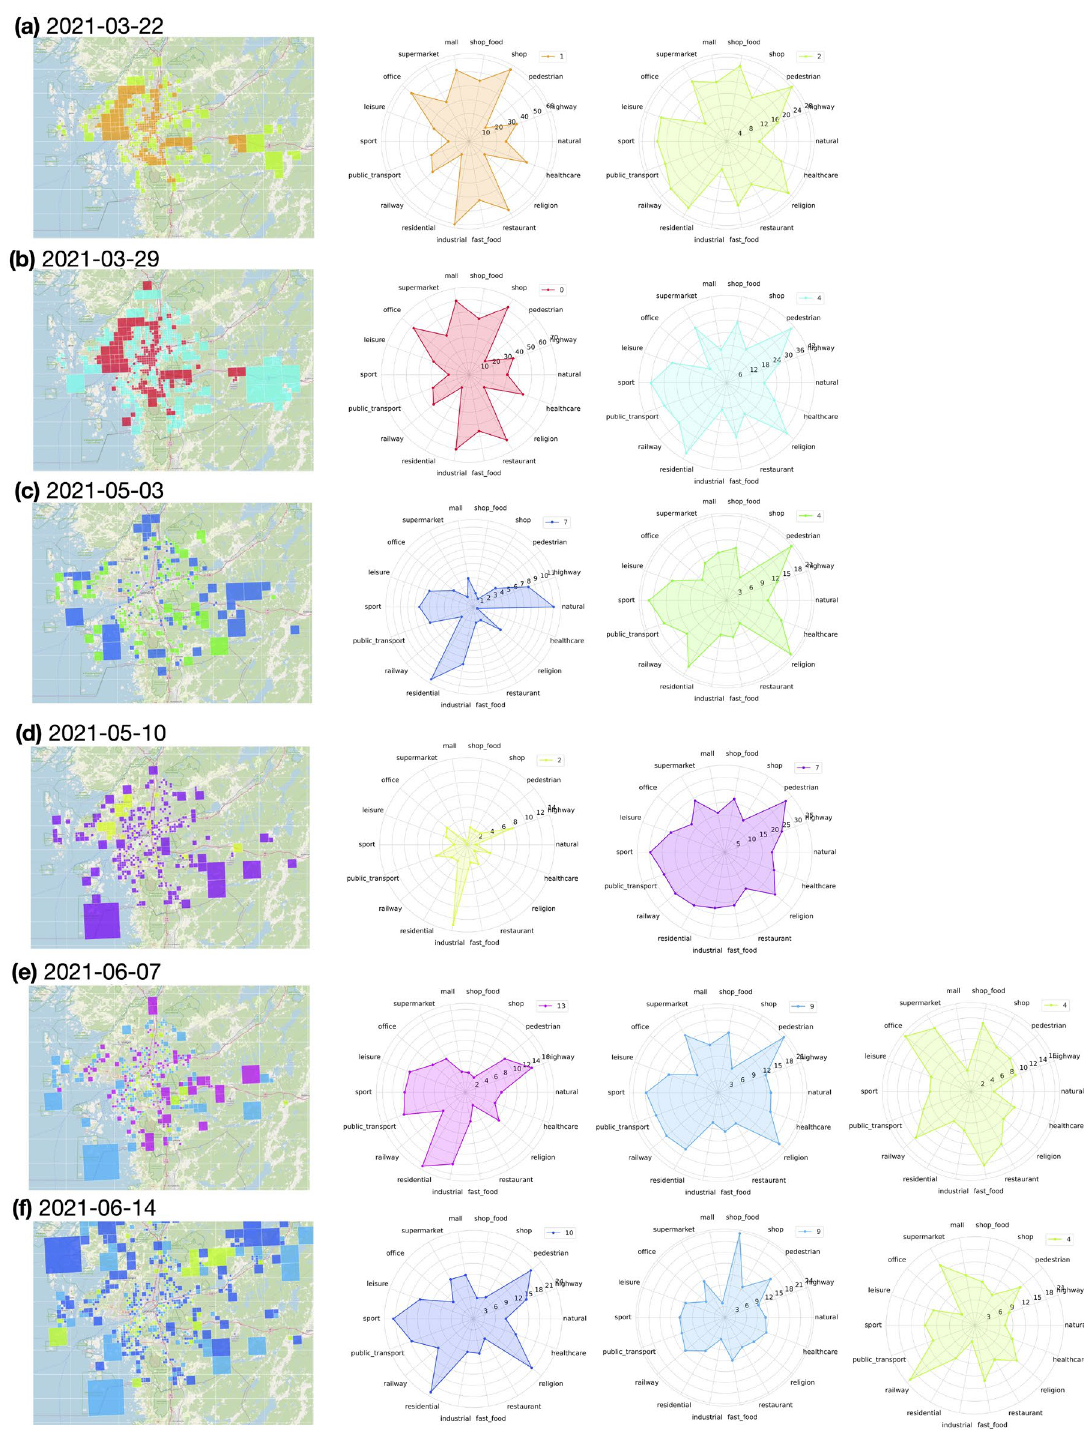
Figure 2. Selected clusters of grids by the grid selection model used in construction of the forecast models for Sahlgrenska University Hospital. ( a – f ) The figure shows the results for selected analysis dates. Note that there is no one-to-one correspondence between the same colors across two arbitrary analysis Fig. 3d shows the occupancy rate of each state, computed from temporal evolution of states. The occupancy rate of states indicates the activity of the states and are between zero and one such that the most active state has the highest occupancy rate. We set a threshold equal to the median of the occupancy rates. The states with occupancy rates greater than the threshold are maintained and are referred to as the active set of states. For the states in the active set of states, we compute the state projections. State projections are computed by multiplying the state posterior probabilities (Supplementary Fig. 3b) to the daily cluster-grid mobile activity